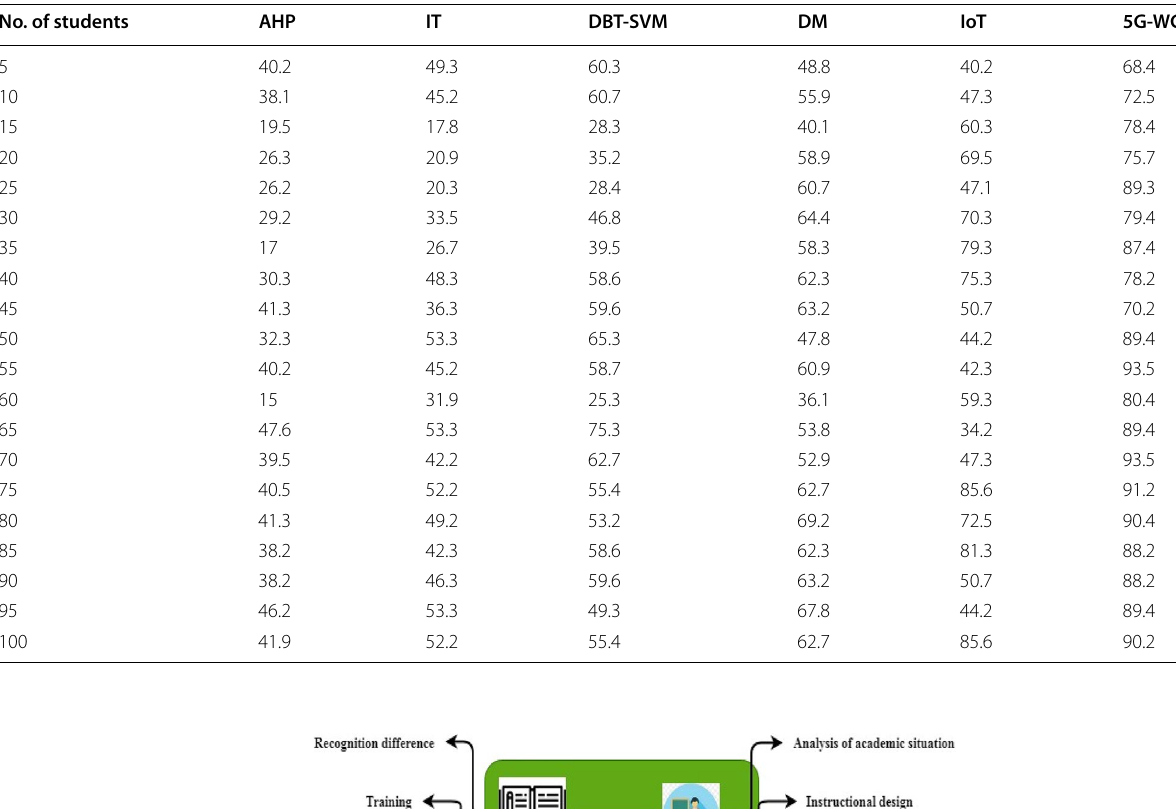
Table 2 Activity ratio of 5G in college classroom education No. of